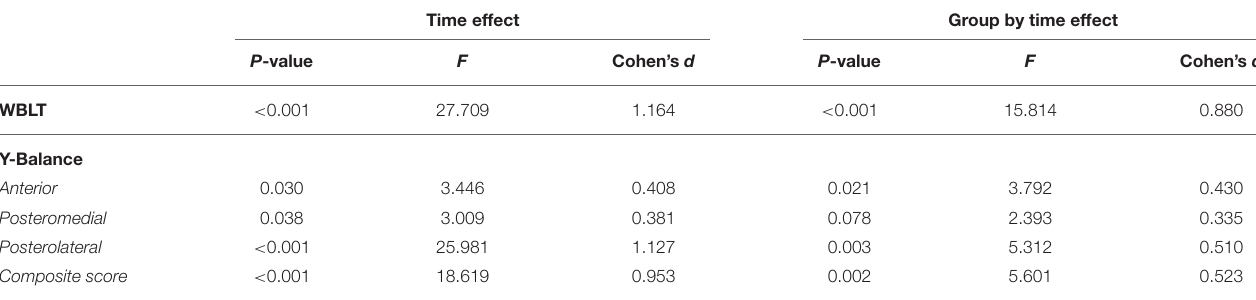
TABLE 2 | Repeated measures ANOVA for time and group by time interaction